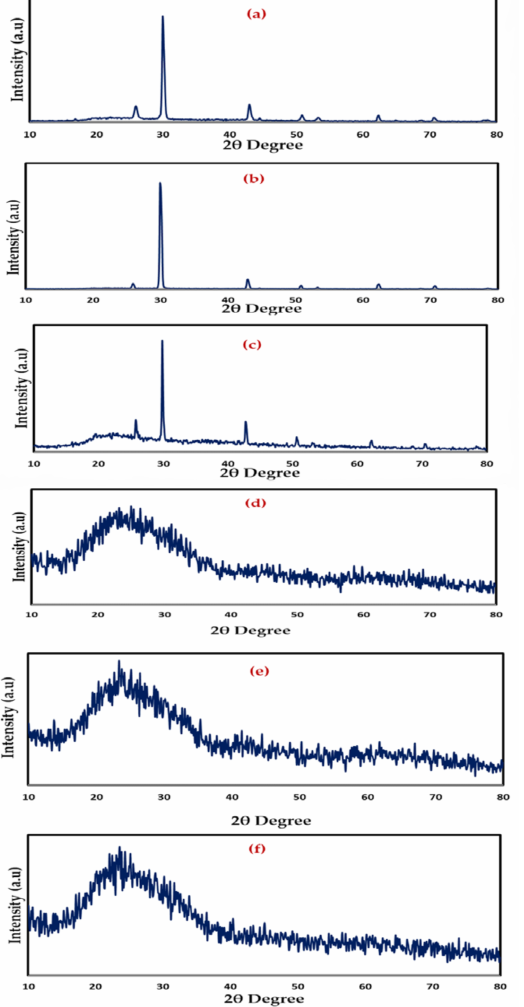
Figure 4. XRD Pattern of ( a ) CSPVNG0, ( b ) CSPVNG11, ( c ) CSPVNG22, ( d ) CSPVNG33, ( e ) CSPVNG44 and ( f )